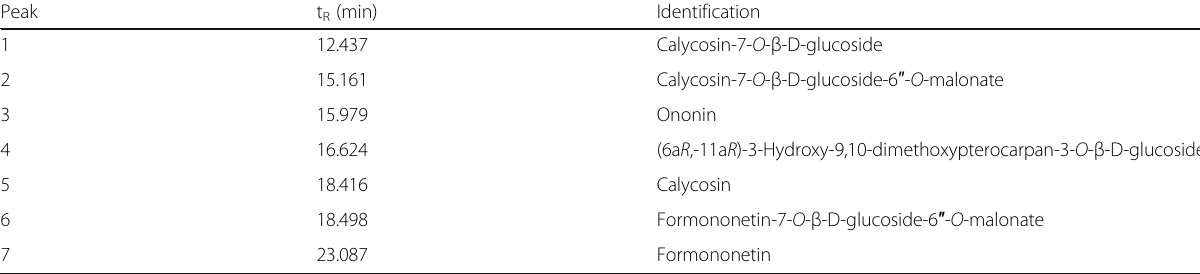
Table 1 Chemical components identified from Radix Astragali by HPLC-ESI/MS n Peak t R (min)